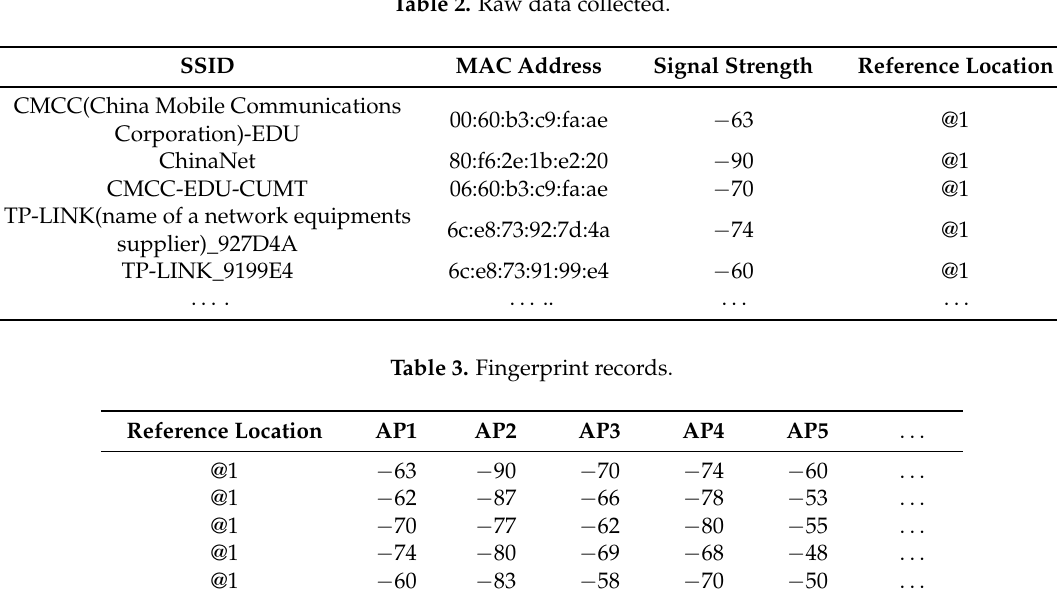
Table 2. Raw data collected.